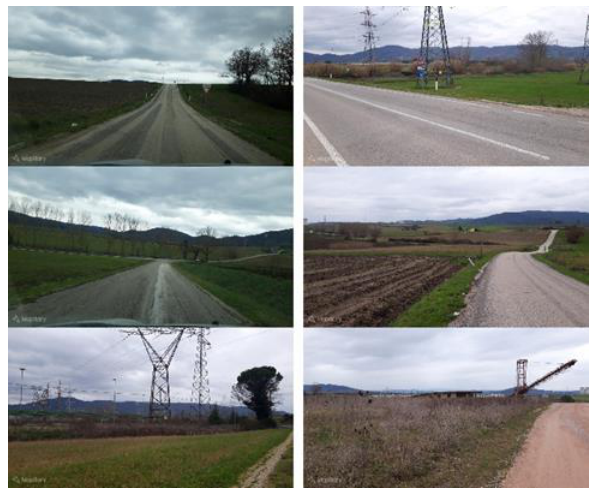
Figure 2 . Some images used for Pietrafitta case